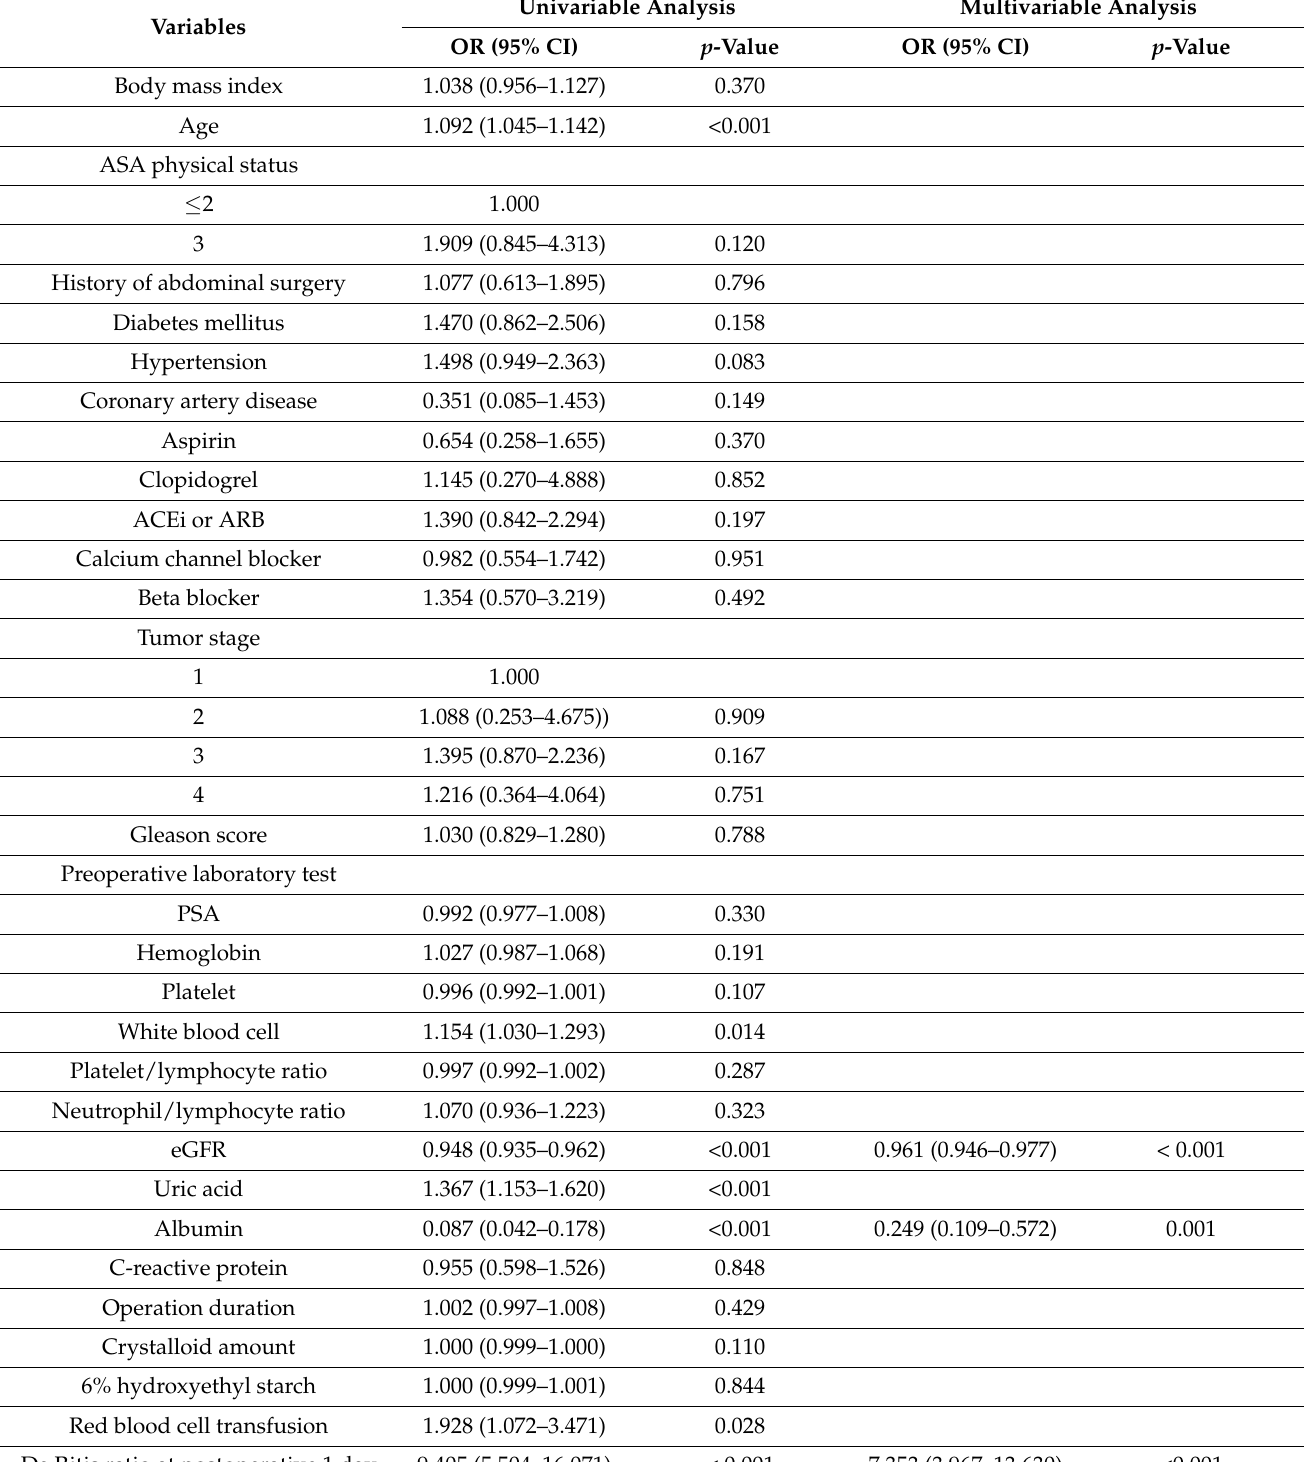
Table 3. Logistic regression analyses of factors associated with postoperative